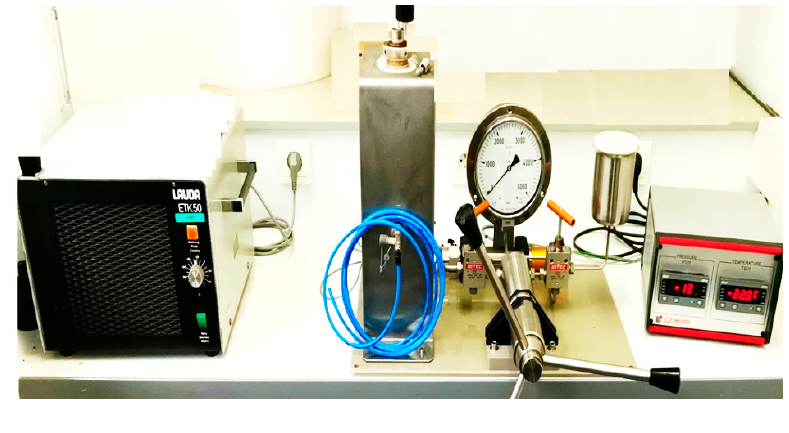
Figure 2. Freeze isostatic pressure equipment at ICMCB.